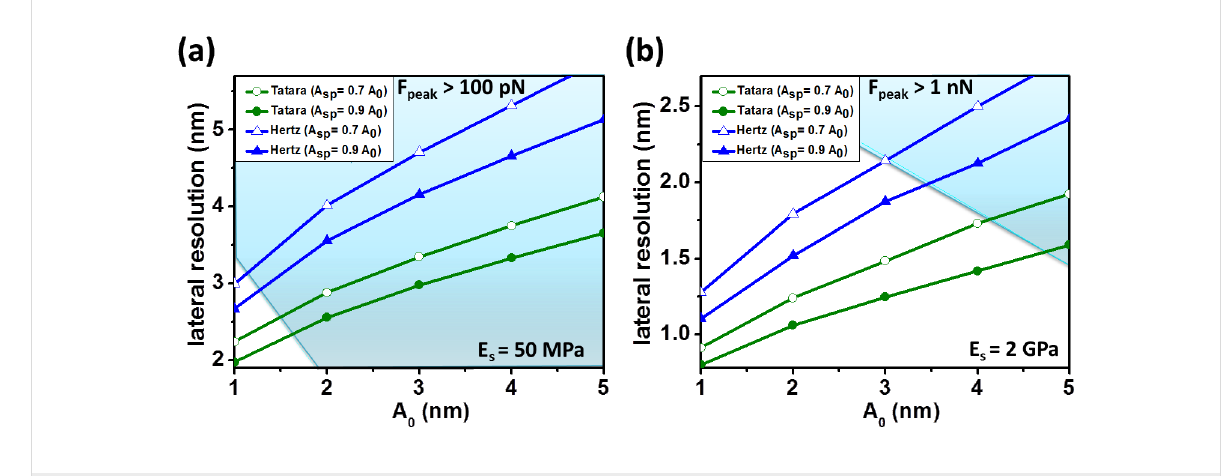
Figure 5: Lateral resolution maps for Hertz and Tatara contact mechanics. (a) E s = 50 MPa. (b) E s = 2 GPa. Filled symbols for A sp = 0.9 A 0 ; empty symbols for A sp = 0.7 A 0 . Circles for Tatara and triangles for Hertz. Simulation inputs: k = 0.1 N/m, f 0 = 25 kHz, Q = 2, A sp = 0.65 A 0 , R t = 5 nm, R s = 4 nm, and two different A sp of 0.9 and 0.7 A 0 ,